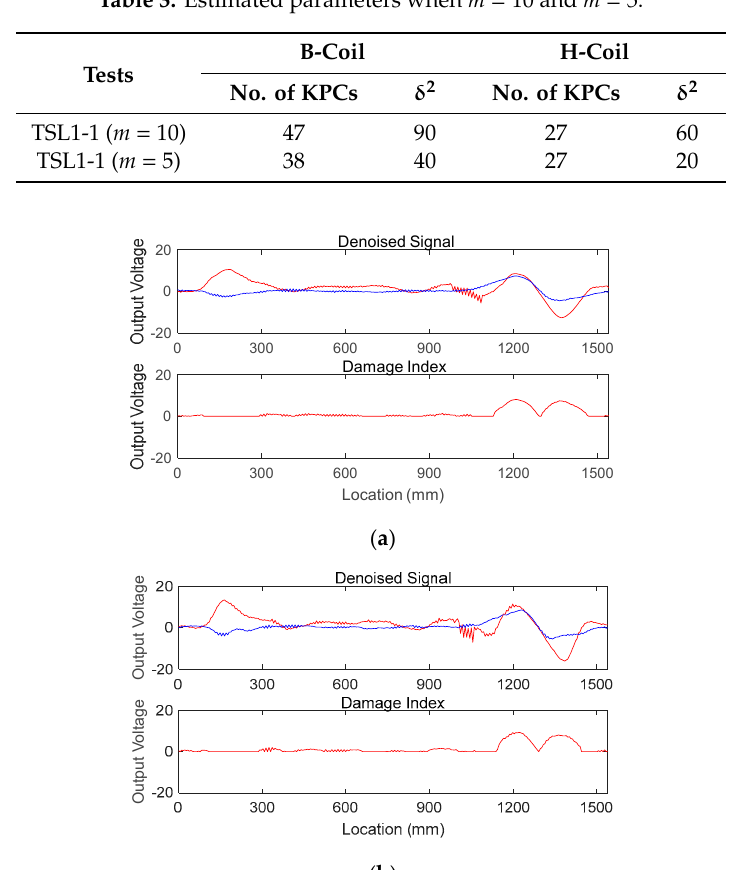
Figure 7. Denoised signal (top) and damage index (bottom) when: ( a ) m = 10; ( b ) m = 5.